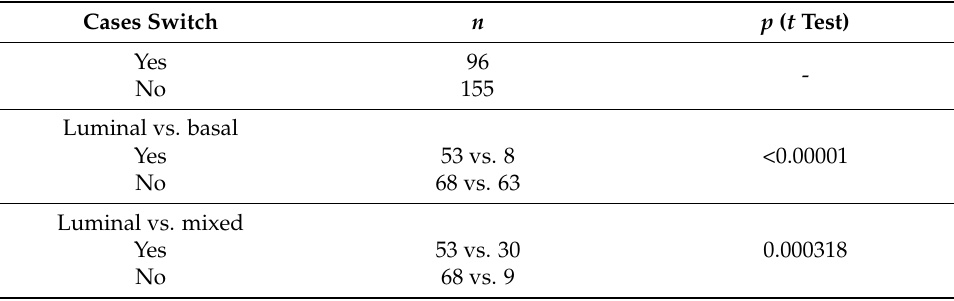
Table 4. Distribution of phenotypical transition in the different categories.